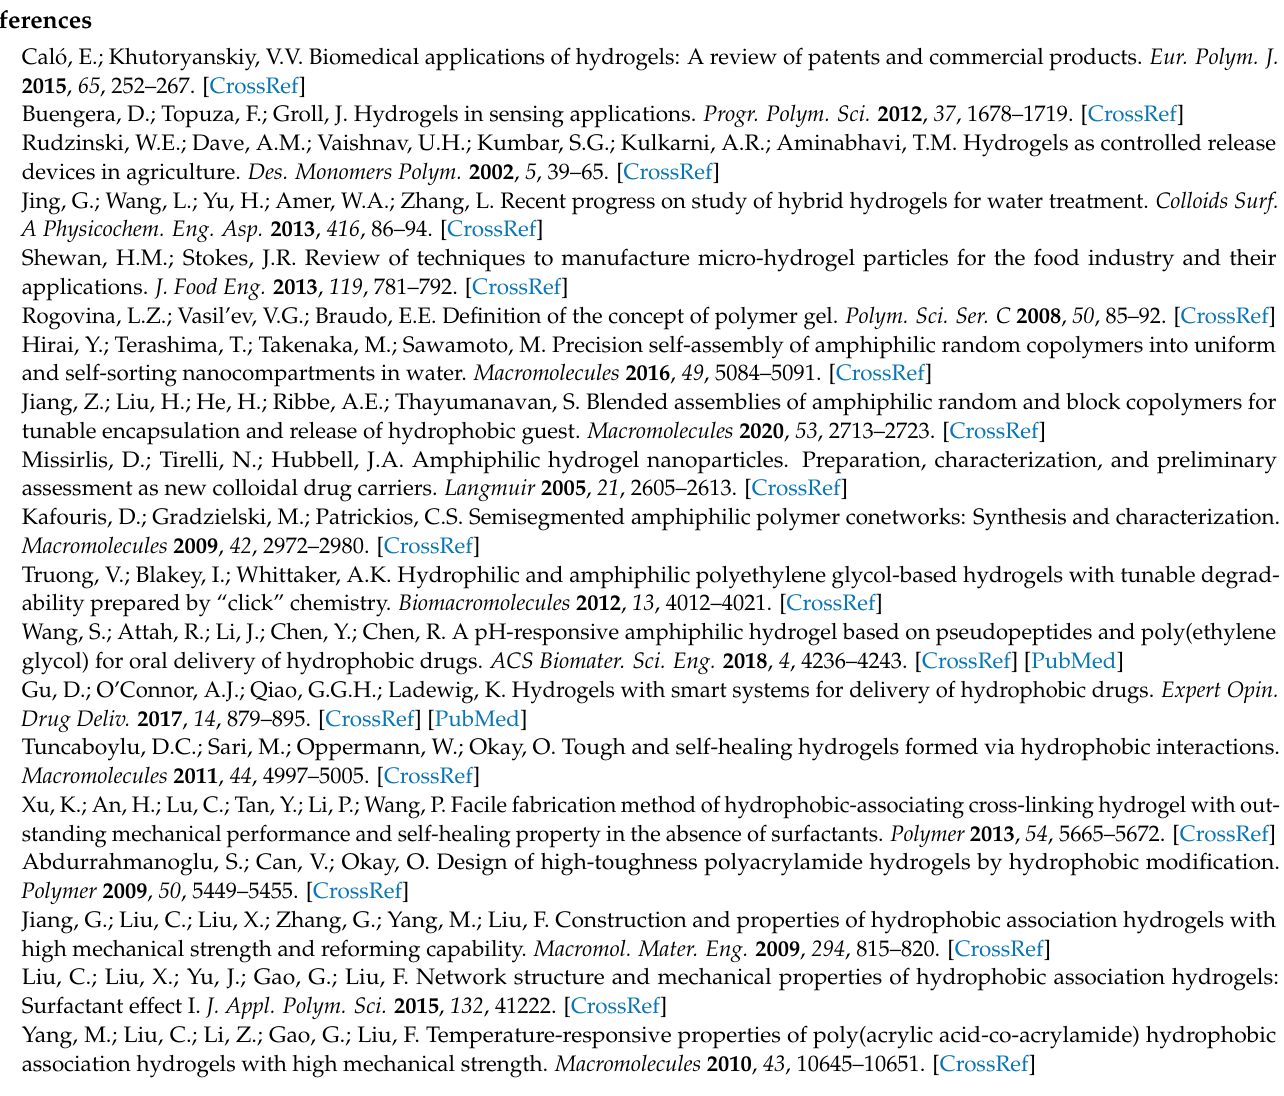
13 of 16 Figure 11. Stress vs. strain behavior of HM hydrogels (tests run in air on specimens equilibrated in NaCl 0.1 M, T = 23°C). ( a ) Hydrogels synthesized using f ODA = 0.75 and the indicated values of f JD400 . ( b ) Hydrogels synthesized using f JD400 = 0.40 and the indicated values of f ODA . Inset: Initial portion of the stress-strain curves. The ODA-free hydrogel is a very weak material with an initial modulus of 8 kPa, an elongation at break of 26% and a stress at break of 1.6 kPa. As the network hydrophobicity increases, all these properties show a considerable increment up to 180 kPa, 450%, and 160 kPa for f ODA = 1, respectively. As a result, the modulus of toughness, i.e., the area under the stress-strain curve up to the break point, is dramatically increased. HM-40-00 contains only covalent cross-links. Hydrogels of this type usually show poor toughness. They re- lieve mechanical stresses mainly by chain rupture. The irreversible nature of this process, combined with cross-link density inhomogeneities, makes them highly susceptible to